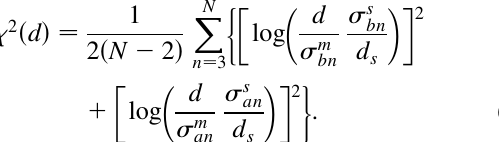
Minimizing the discrepancy with respect to d , we obtain the standard deviation d of the reproducibility of coil 0 positioning that best fits the measured multipole spread